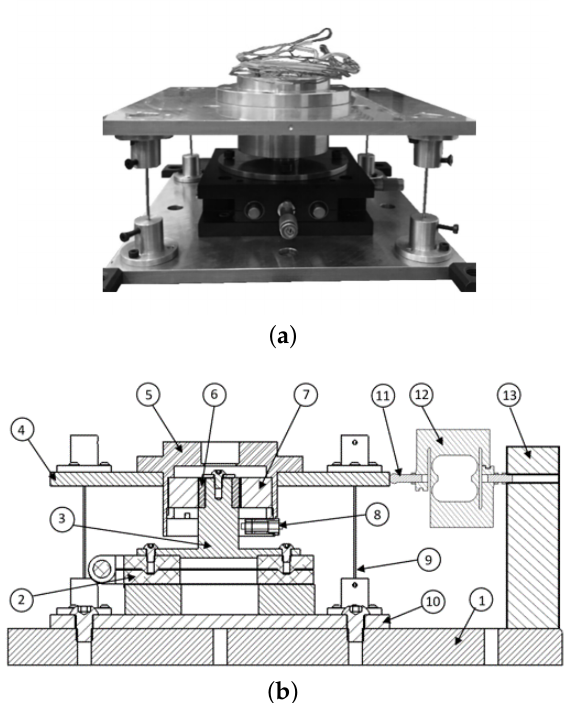
Figure 1. Experimental test rig ( a ); section view of the experimental setup ( b ): 1. Seismic mass; 2. Micrometric planar positioning stage; 3. Support of the journal; 4. Upper plate; 5. Housing of the electromagnetic actuators; 6. Journal; 7. Cores of the electromagnets; 8. Proximitor sensor; 9. Flexible beams; 10. Lower plate; 11. Load cell-upper plate interface; 12. Load cell; 13. Seismic mass. Table 1 resumes the main parameters of the electromagnetic actuators and the journals. Note that both the soft iron and the FeCrCo 48/5 SHMM journals have identical